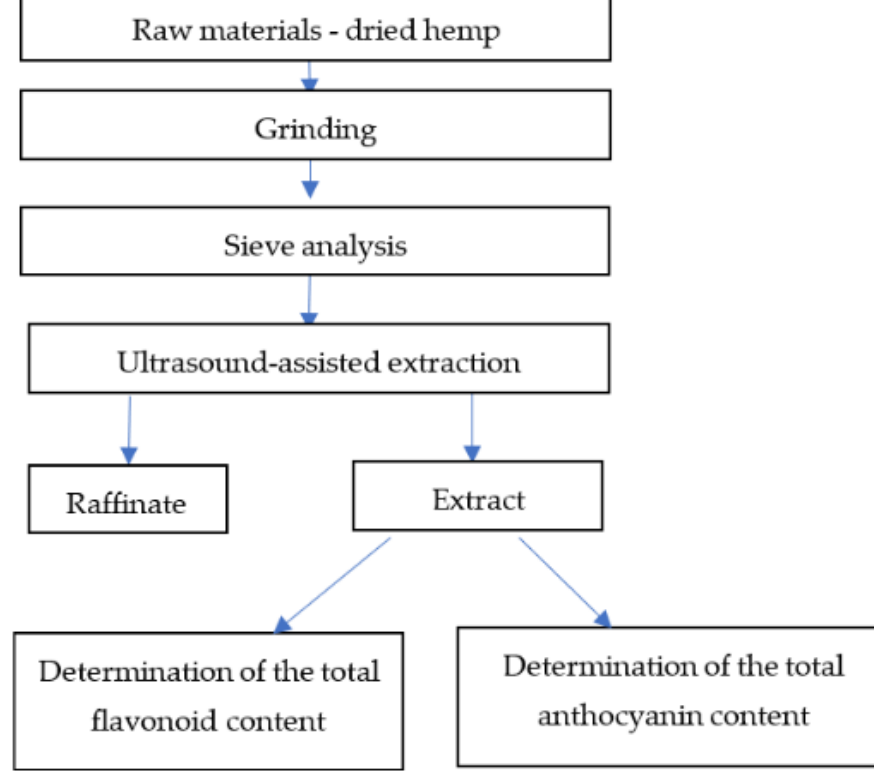
Figure 1. Scheme of the conducted research.